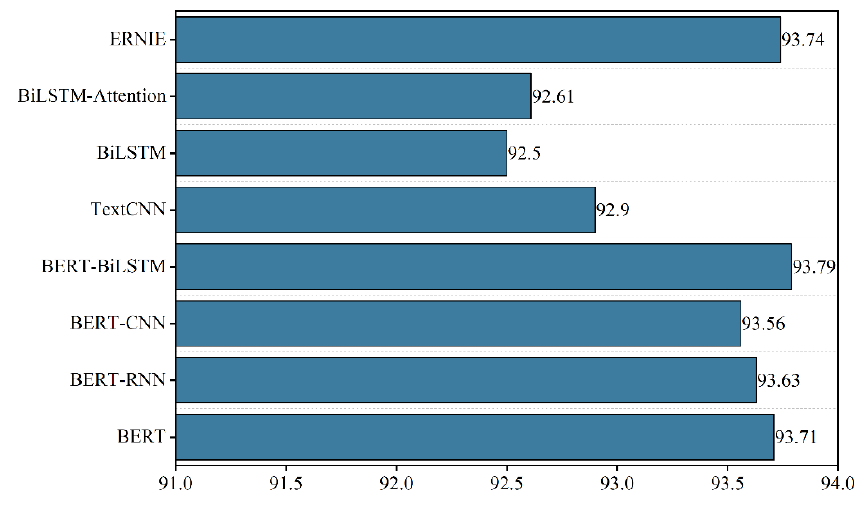
Figure 8. F1‑score comparison chart for each experiment. Figure 8. F1-score comparison chart for each experiment.